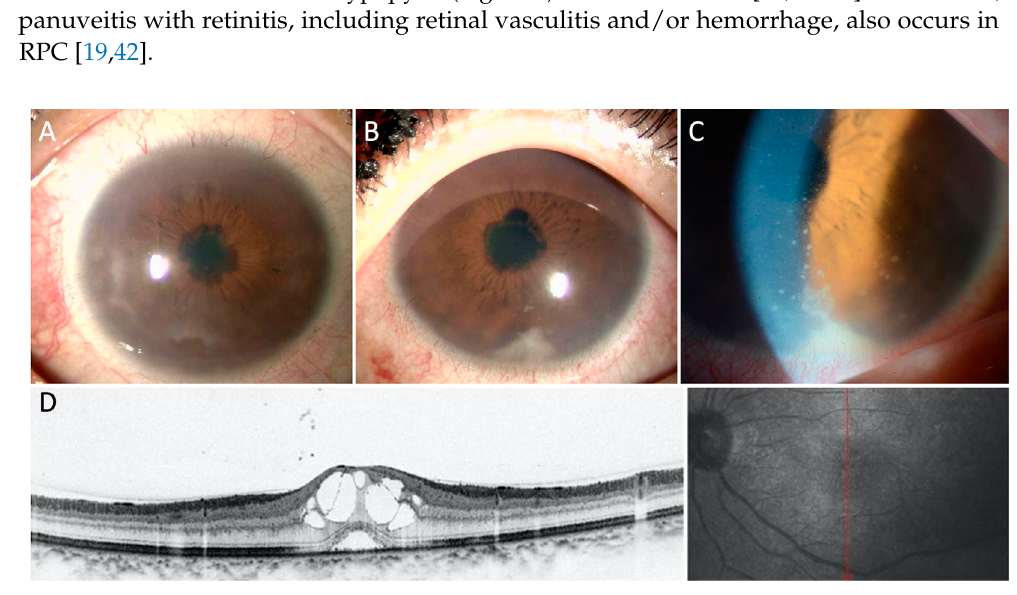
Figure 3. Bilateral anterior uveitis with macular edema in a patient with RPC. Photographs show bilateral anterior uveitis with posterior synechia ( A , B ). Keratic precipitates and hypopyon are also observed in left eye ( B , C ). OCT depicts cystoid macular edema ( D ).